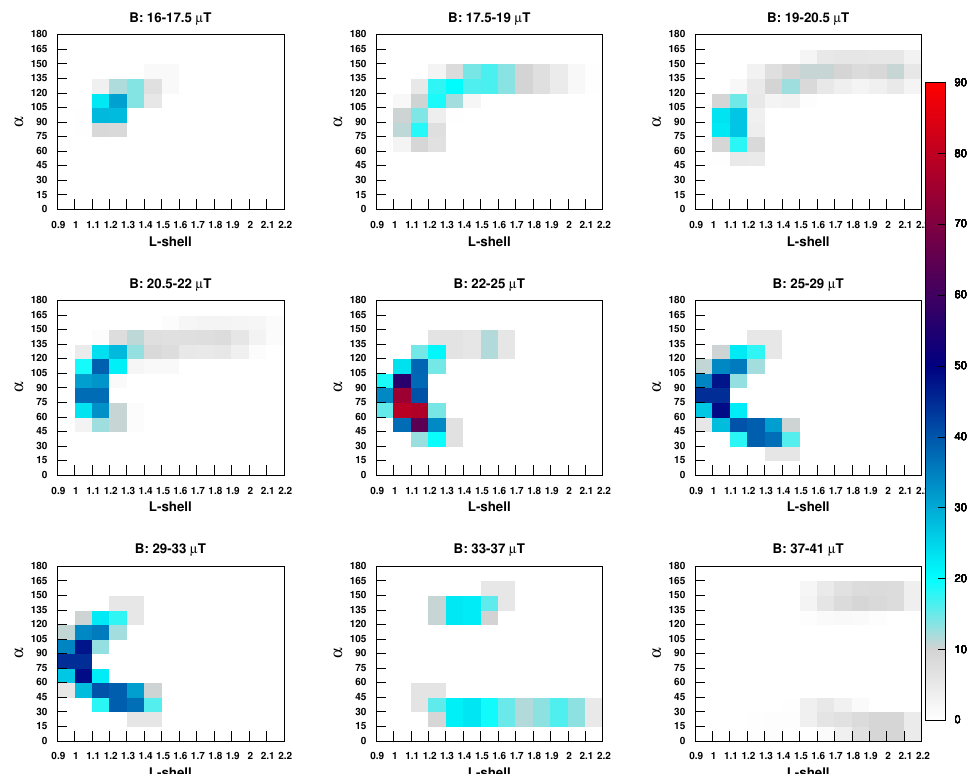
Figure 13. Count rate (CR) daily average data availability in (L, α , B) cell on 30 October 2020. The colorbar denotes the number of times the satellite passes through the same cell. The satellite passes the maximum number through the geomagnetic field value B = 22.0–25.0 µ T. CRs that exceed four times the standard deviation, according to the Poisson distribu- tion, are detected as non-Poisson fluctuations with a probability of 99%, and these CRs are called particle burst events [82,83]. To eliminate the normal background statistical fluctuation, we set a constraint to eliminate the same by computing the σ values of the particle counts profile. In Figure 14, we present the 8 second average of particle counts and the computed 4 σ level. The particles that crossed this level of 4 σ are treated as the particle bursts, and the remainder of the number of particles are viewed as the normal statistical fluctuation. Here, the x -axis demonstrates the electron included in 8 s average and, along with the y -axis, it shows the daily energetic particle count numbers. The blue dashed line demonstrates the 4 σ level. For this EQ, the estimation of this 4 σ is